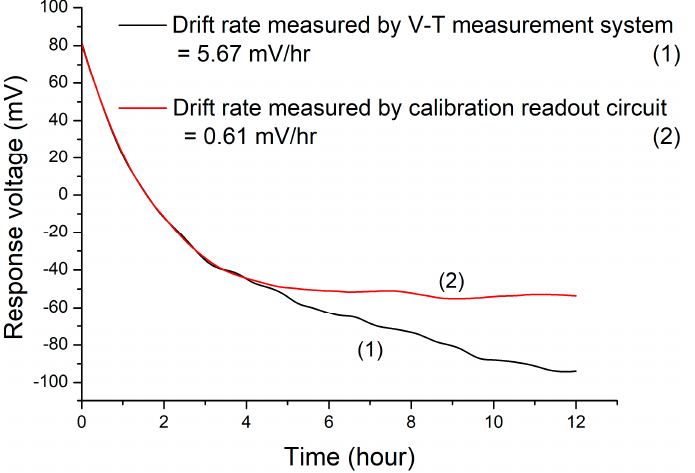
Figure 10. Drift rates of the CZO sensor after using the calibration readout circuit.